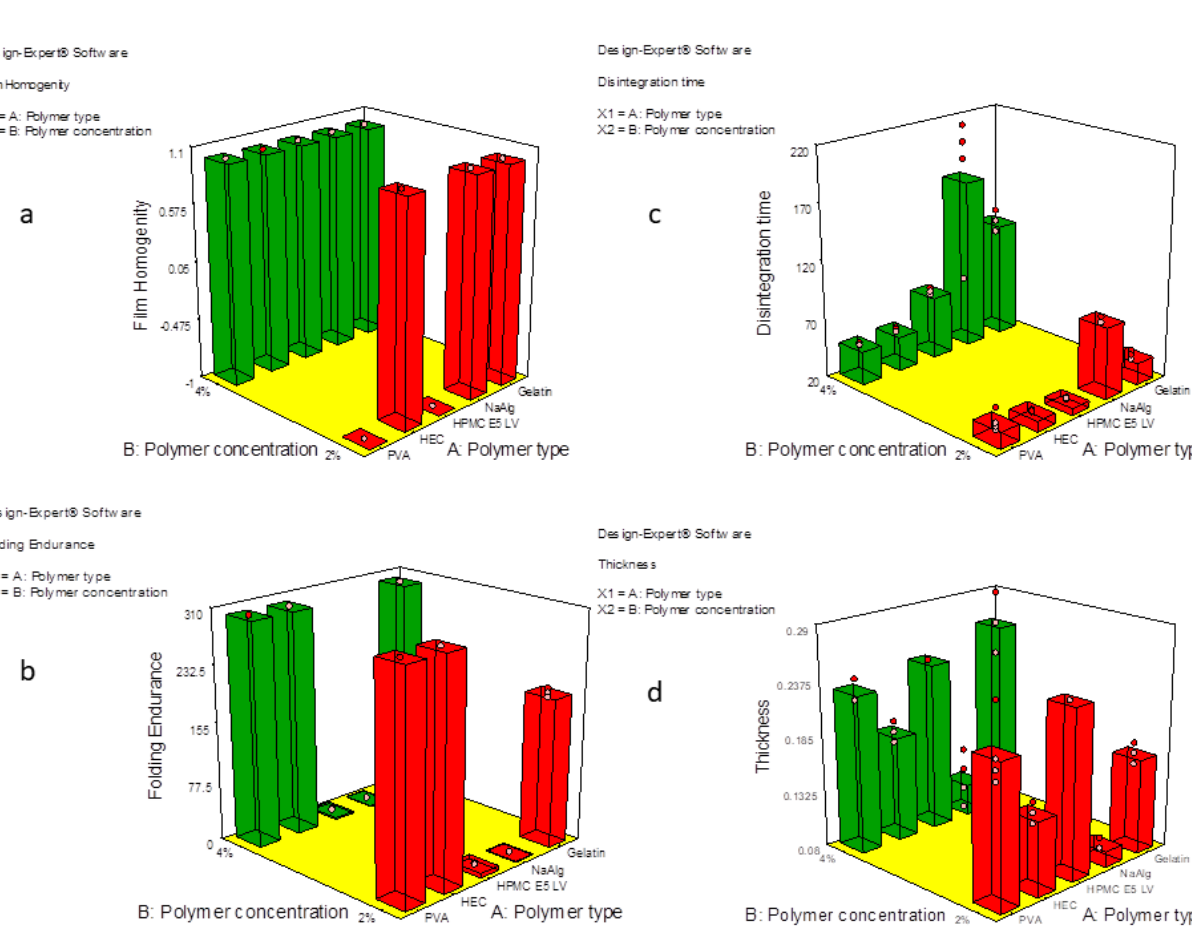
FIGURE 5 - Response surface plot for the effects of polymer type and polymer concentration on (a) film homogeneity (b) Folding endurance (c) Disintegration time and (d) Thickness of SRT